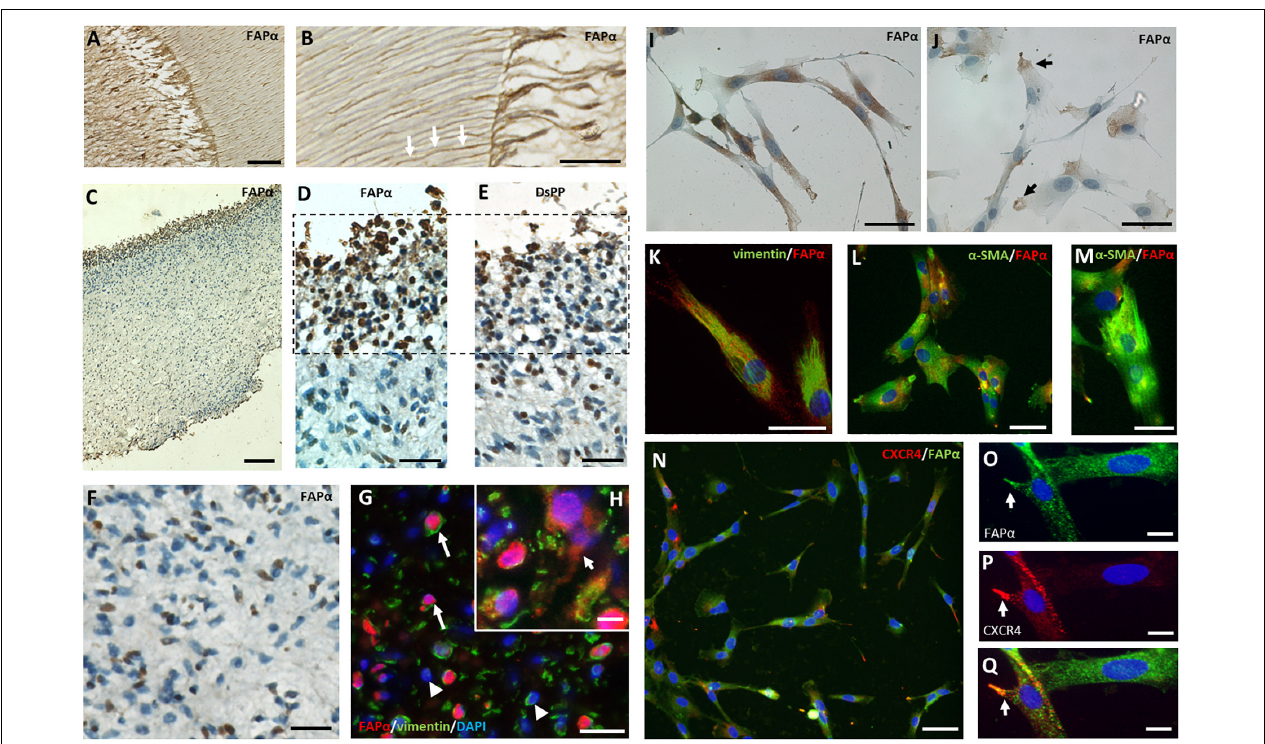
FIGURE 4 | FAP α expression in dental pulp tissue and stem cells. (A) Immunohistochemistry staining of FAP α in a decalcified intact molar showing the dentin-pulp region. (B) Higher magnification displays FAP α + odontoblasts with their corresponding protrusions entering the dental tubules. (C) FAP α staining of extracted pulp tissue. (D) Serial sections demarking the presence of FAP α (D) and DSPP (E) positive odontoblasts at the periphery of the extracted pulp tissue. (F) Immunohistochemistry staining of FAP α in the coronal center of extracted pulp tissue. A heterogeneous population of FAP α expressing cells is visible. (G,H) Double immunofluorescent staining of FAP α (red) and vimentin (green) with nuclear counterstaining (DAPI, blue) in matched dental pulp tissue. Indicated cells are FAP α + /vimentin + (arrow) and FAP α − /vimentin + (arrowhead). Insert (H) showing FAP α + staining in the plasma membrane (arrow). (I) Immunocytochemistry staining of FAP α in cultured DPSC’s showing localization in the plasma membrane (I) or limited to the pseudopodia (J) . Double immunofluorescent staining of cultured DPSCs indicates co-expression of FAP α with either vimentin ( K , green) or diffuse α -SMA ( L , green). Only a limited number of cells have organized α -SMA stress fibers (M) . (N–Q) Double immunofluorescent staining of FAP α (green) and CXCR4 (red) with nuclear counterstaining (DAPI, blue). Co-localization of FAP α (O) and CXCR4 (P) with the matching overlay image (Q) . Scale bars represent 25 (B,D,E,F,H,K,M,O–Q) , 50 (A,I,J,L,N,G) , and 100 (C) µ